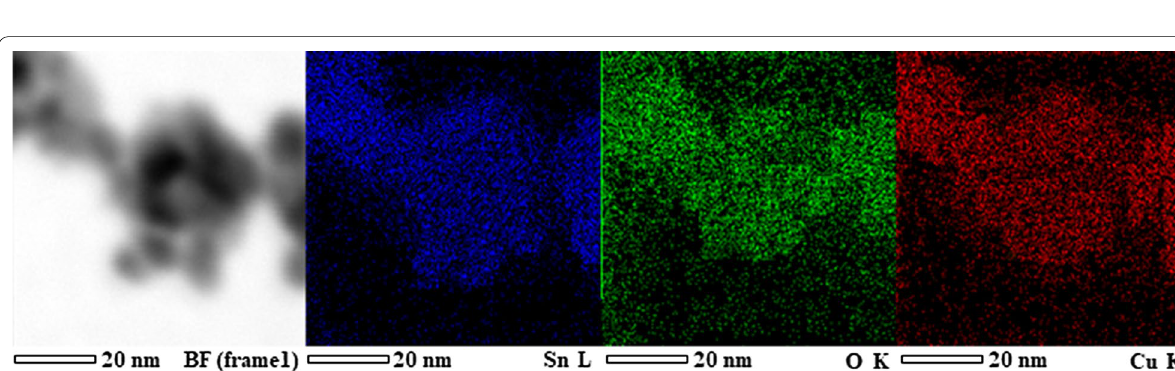
Fig. 5 Scanning-TEM (STEM) image and corresponding elemental EDS maps of 20 wt% CuO/SnO 2